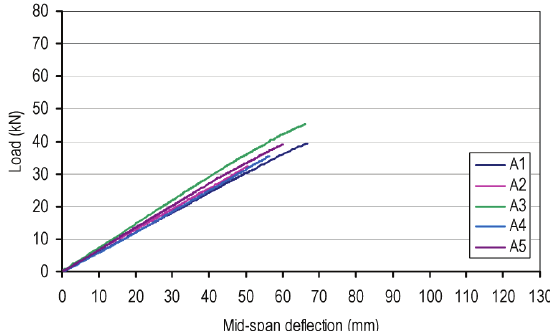
Fig. 4. Load-deflection behaviour for unreinforced beams (Series A)